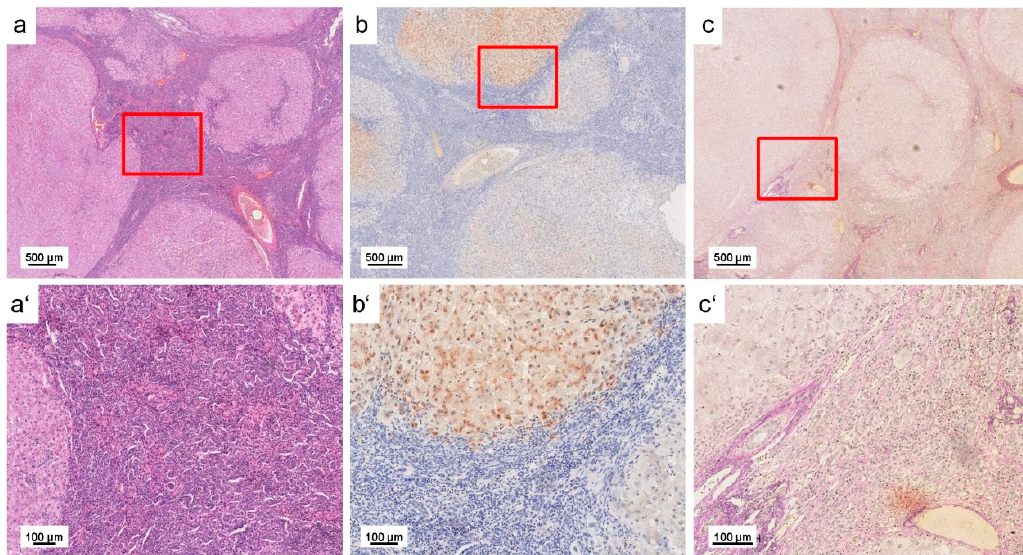
Figure 2. Liver pathology in Wilson disease as assessed by standard histochemical stains relying on chemical reactions. Liver specimens from a patient suffering from Wilson disease were stained with ( a and a’ ) hematoxylin & eosin, ( b and b’ ) rhodanine, and ( c and c’ ) Verhoeff-van Gieson. The hematoxylin & eosin and the Verhoeff-van Gieson stains show established bridging fibrosis (cirrhosis) and liver damage, respectively. Cytoplasmic Cu accumulation is well-documented in the rhodanine stain. Space bars represent 500 µm ( a , b , and c ) or 100 µm ( a’ , b’ , and c’ ), respectively.